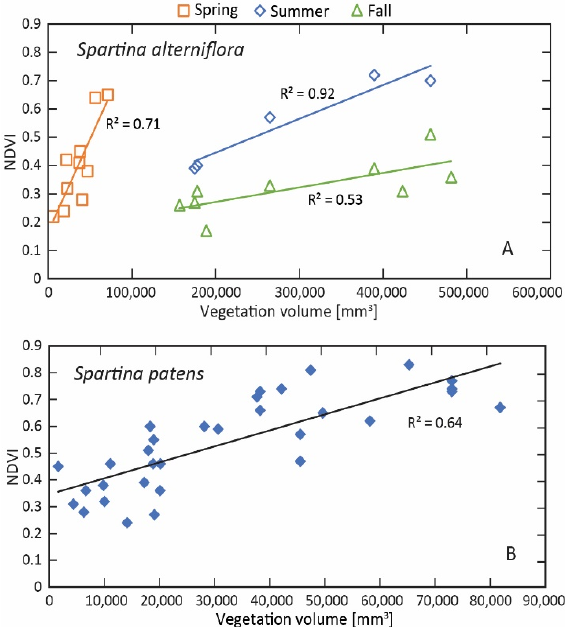
Figure 8. Vegetation characteristic from survey and remote sensing data divided by the two main marsh species present in the study site: ( A ) Spartina alterniflora and ( B ) Spartina patens . Plot ( A ) shows through colors and shapes the marsh field measurements and relative NDVI divided by the three